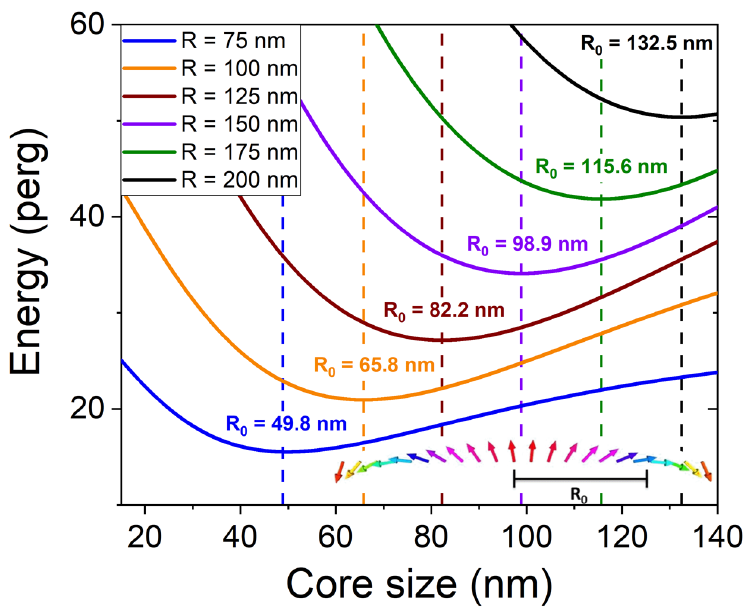
Figure 10. Energy vs. core radius for different dot radii. The calculation parameters are: dot thickness = 1.4 nm, M = 1220 emu/cm 3 , K = − 1.04 erg/cm 3 , D = − 1.34 erg/cm 2 , A = 1.6 µ